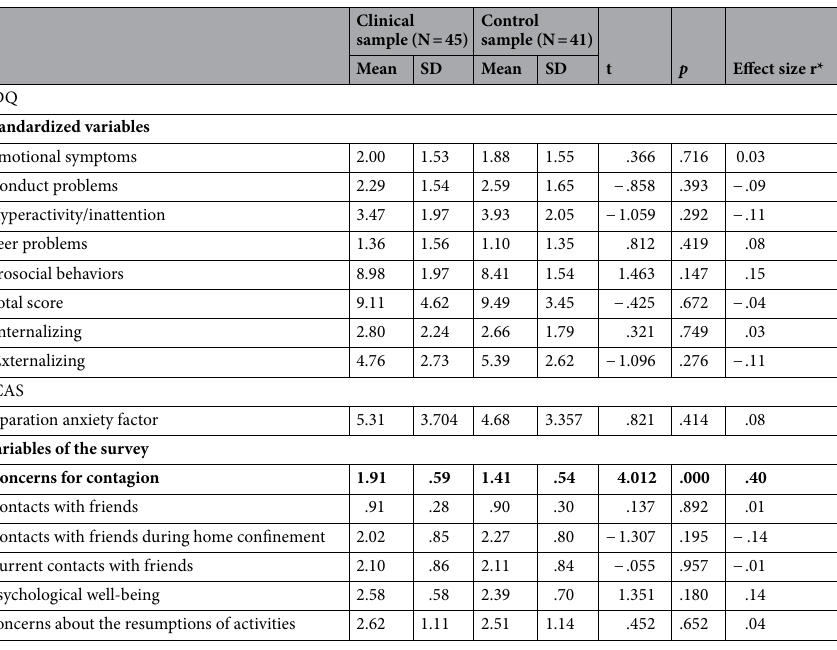
Table 2. Differences between clinical and control children samples’ scores in standardized questionnaires and in some selected variables of the ad hoc survey calculated using student’s T-test. Standard deviations are reported. Bold for p -values < .05. *Note: effect size’s r values: .00–.20 low, .30–.50 medium, .60–2.00 large.